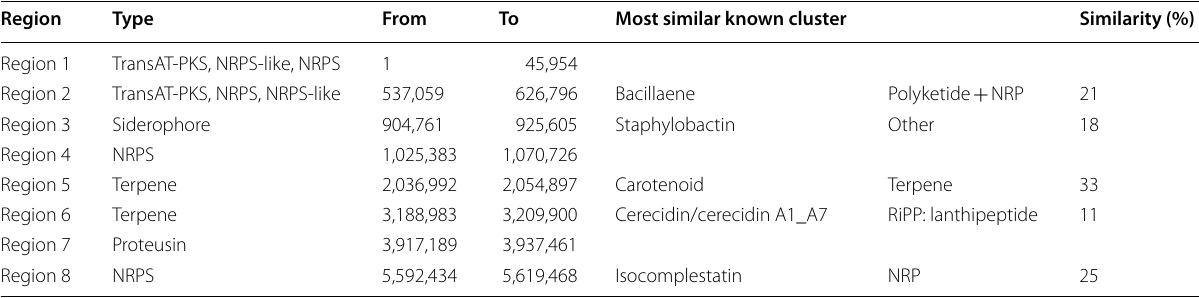
Table 3 Predicted secondary metabolite loci in the S. brassicae ATSA2 T